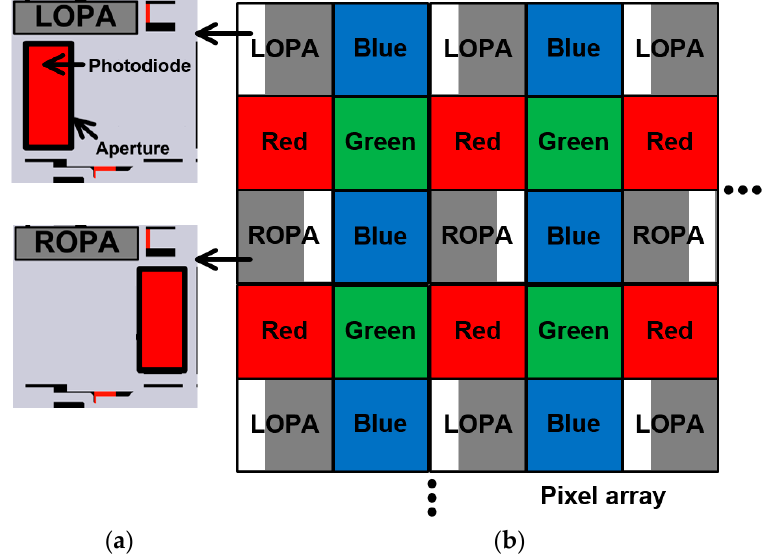
Figure 6. ( a ) Layouts of the LOPA and ROPA pixels and ( b ) color pattern of the pixel array.